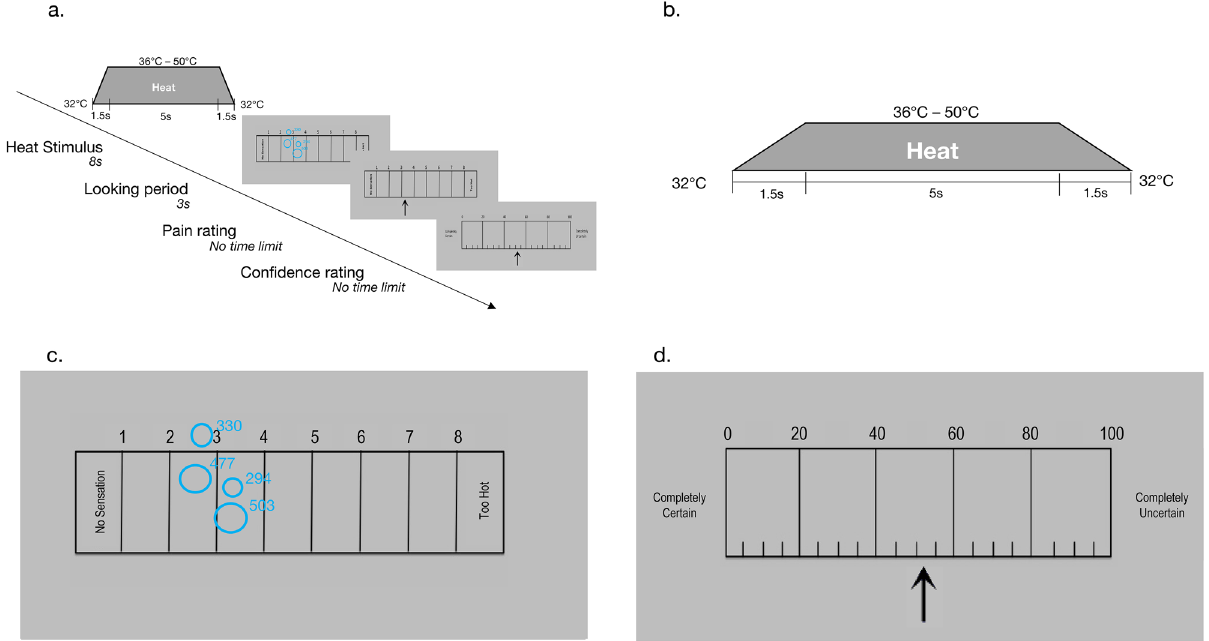
Figure 1. Task design. A. Schematic of trial design. Trials began with a Heat Stimulus, followed by a three- second looking period, during which participants could look at the pain rating scale (while their eye movements were tracked) but could not make a pain rating. After three-seconds of pain rating scale presentation, an arrow appeared on the scale and participants made a pain rating for the preceding stimulus. Finally, participants provided confidence ratings. There was no time limit for pain ratings or confidence ratings. B . Heat stimulus. Each 8-s heat stimulus included 5 s of stimulation at a peak destination temperature ranging from 36 °C to 50 °C, as well as 1.5-s ramps to and from a baseline of 32 °C. After 5 s at peak temperature, the stimulus ramped down to 32 degrees Celsius in 1.5 s. C . Looking period. Example of gaze position data during the Looking period, prior to pain rating. Each circle represents a fixation on the pain rating scale. Area and numbers denote the duration of the fixation, which was not used for the current analysis. D . Confidence rating. Following pain rating, participants rated their confidence using a visual analogue scale that ranged from “Completely Certain” to “Completely